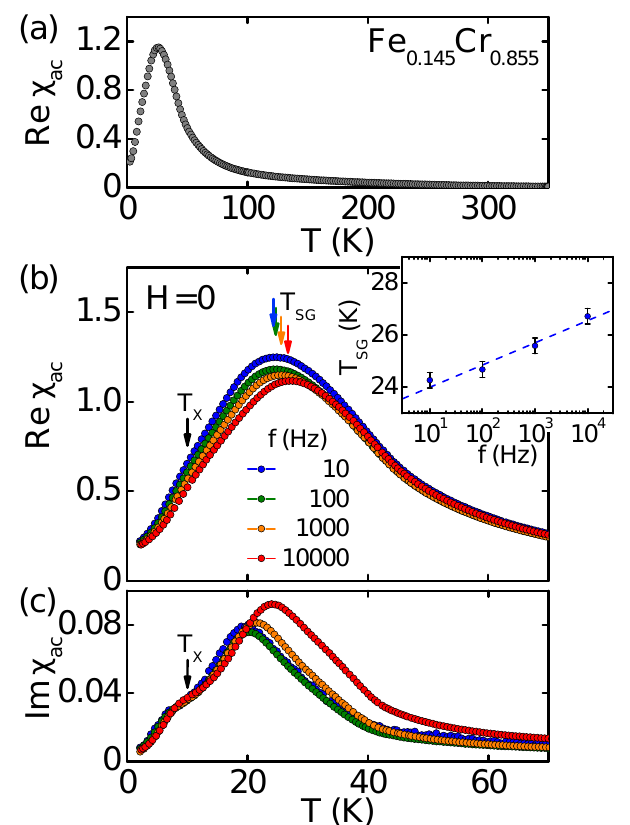
Figure 1. Temperature dependence of the alternating current (AC) susceptibility of the studied sample. ( a ) real part of the AC susceptibility between 2K and 350K measured at 911Hz. The absolute value is large, when compared with a typical antiferromagnetic compound; ( b ) real part of the AC susceptibility, Re χ ac , as measured at low temperatures for excitation frequencies between 10Hz and 10kHz. As depicted in the inset and characteristic for a spin glass, the position of the maximum at T SG shifts clearly as a function of the excitation frequency; ( c ) imaginary part of the AC susceptibility, Im χ ac , at low temperatures. A change of slope at T x ∼ 10K in Re χ ac and, in particular, in Im χ ac suggests the presence of an additional transition, which is not captured in the neutron data and will not be considered further.